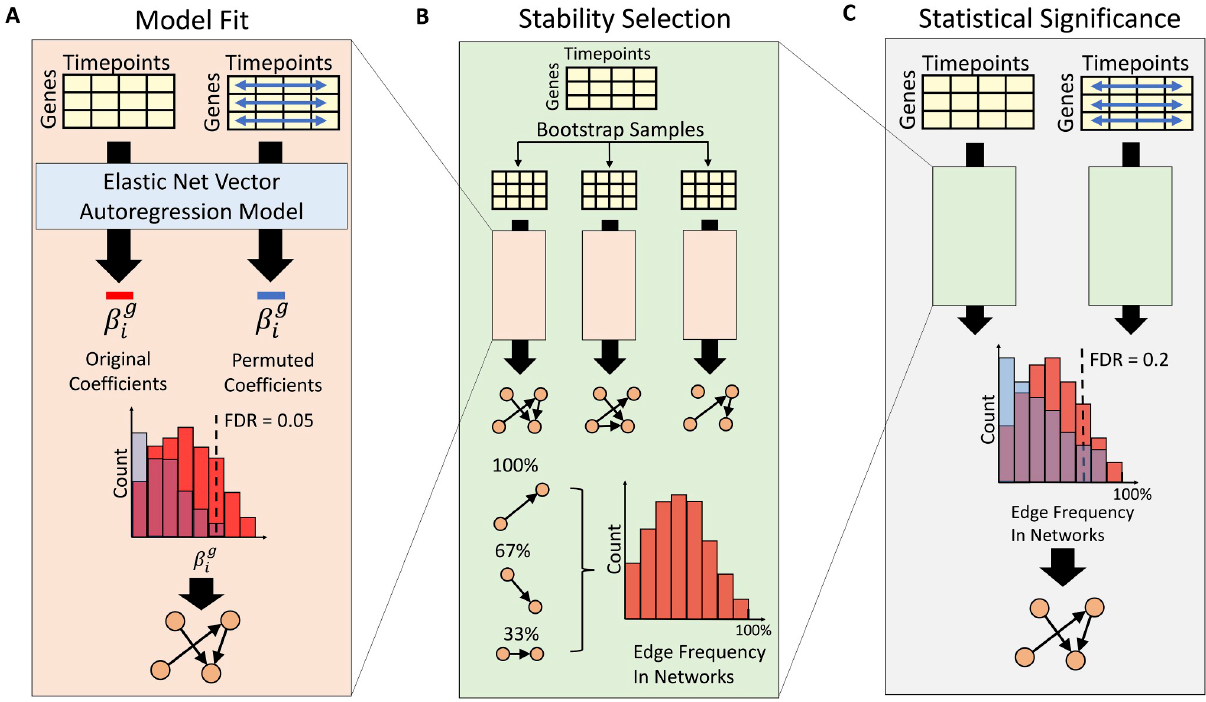
Fig 1. BETS Algorithm. A) Model fit . The VAR model is fit on both the original and a permuted data set (blue arrows indicate shuffling each gene’s expression independently across time). Based on the null distribution of coefficients, a threshold is chosen to control the edge FDR at � 0.05. B) Stability selection . From the original data, 1000 bootstrap samples are generated. For each sample, a network is inferred as in A. Each edge’s selection frequency across the bootstrapped networks is computed. C) Statistical significance . For both the original and permuted data, a selection frequency distribution is generated for stability selection as in B. Edges are thresholded to control the stability FDR at � 0.2. See S1 Fig for an overview of network inference methods.